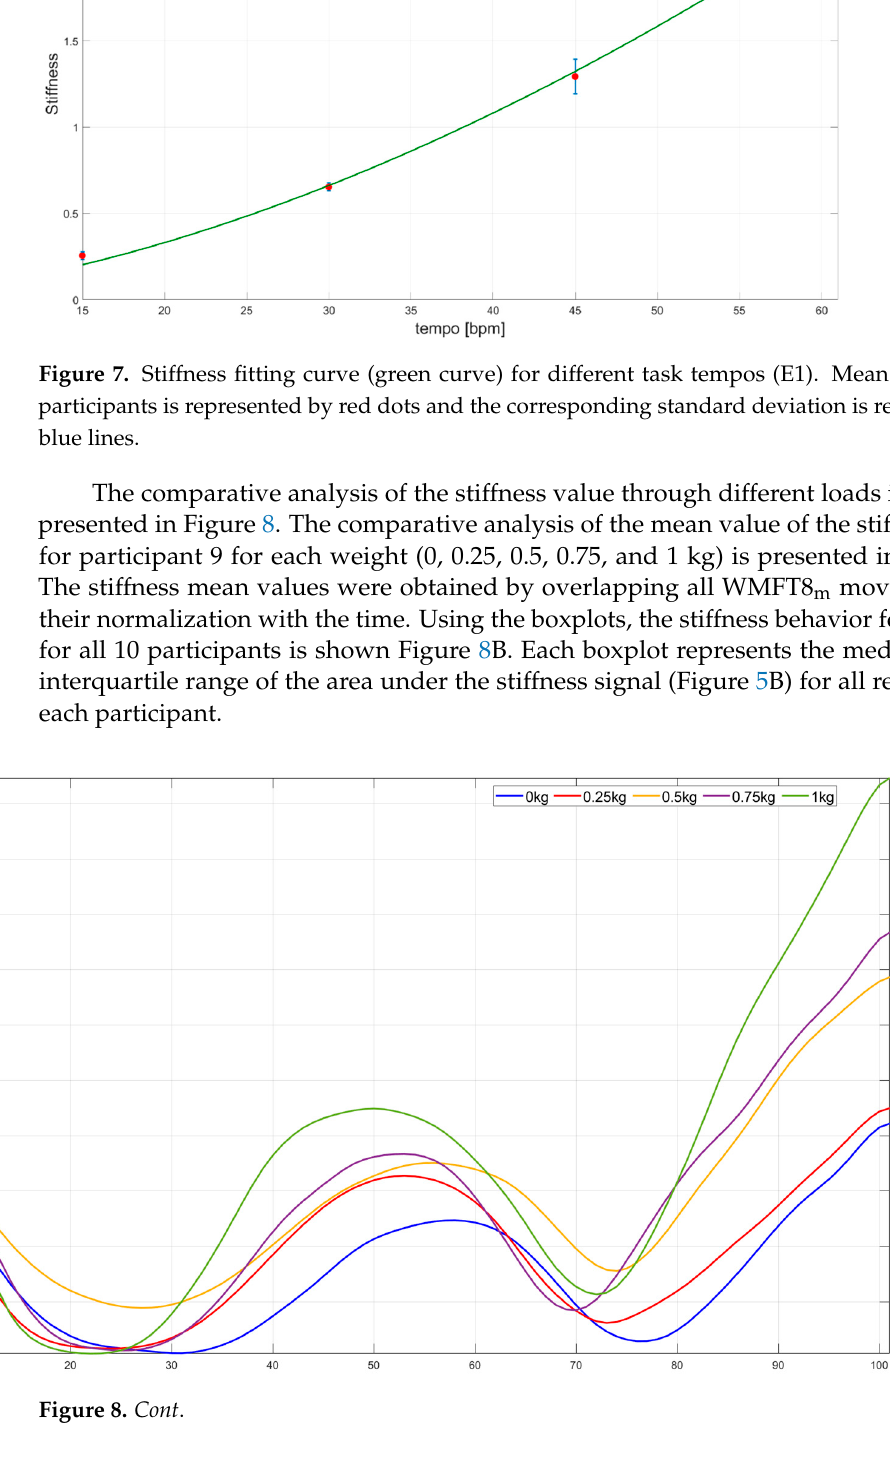
Figure 8. Comparative analysis of ( A ) elbow joint stiffness mean value for participant 9; ( B ) stiffness value for each tempo for all 10 participants in task E2.